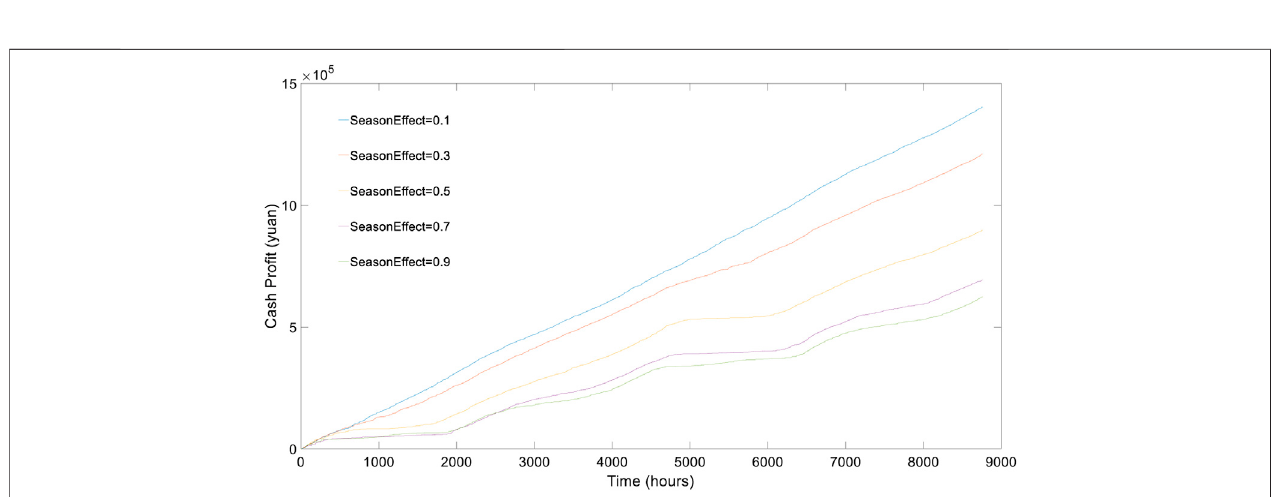
FIGURE 6 | Total cash fl ows with different seasonal factors of electricity price (for one